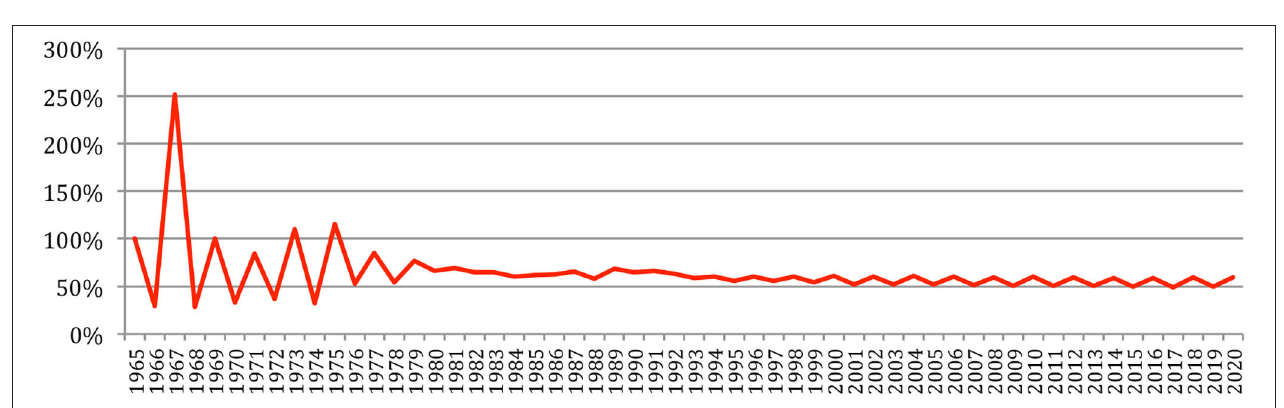
FIGURE 2 | Increase in the number of papers over the years.